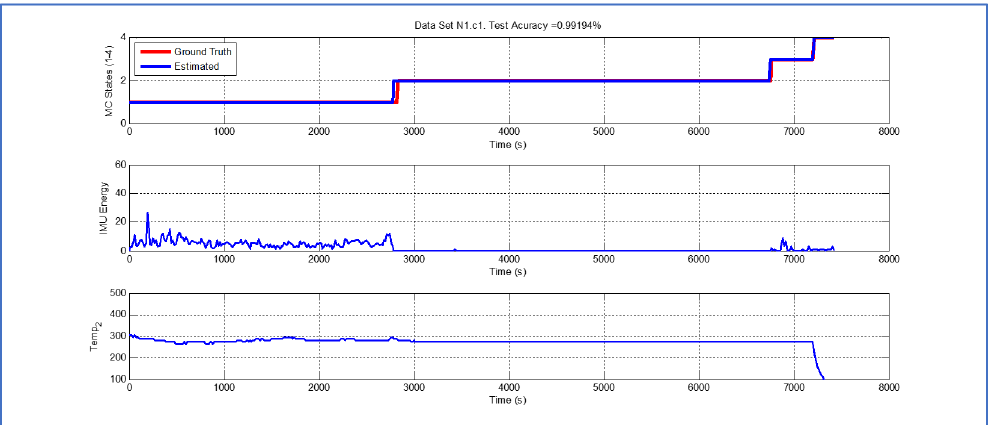
Figure 6. Detection of berry harvesting stages. Dataset N 1 c 1 .